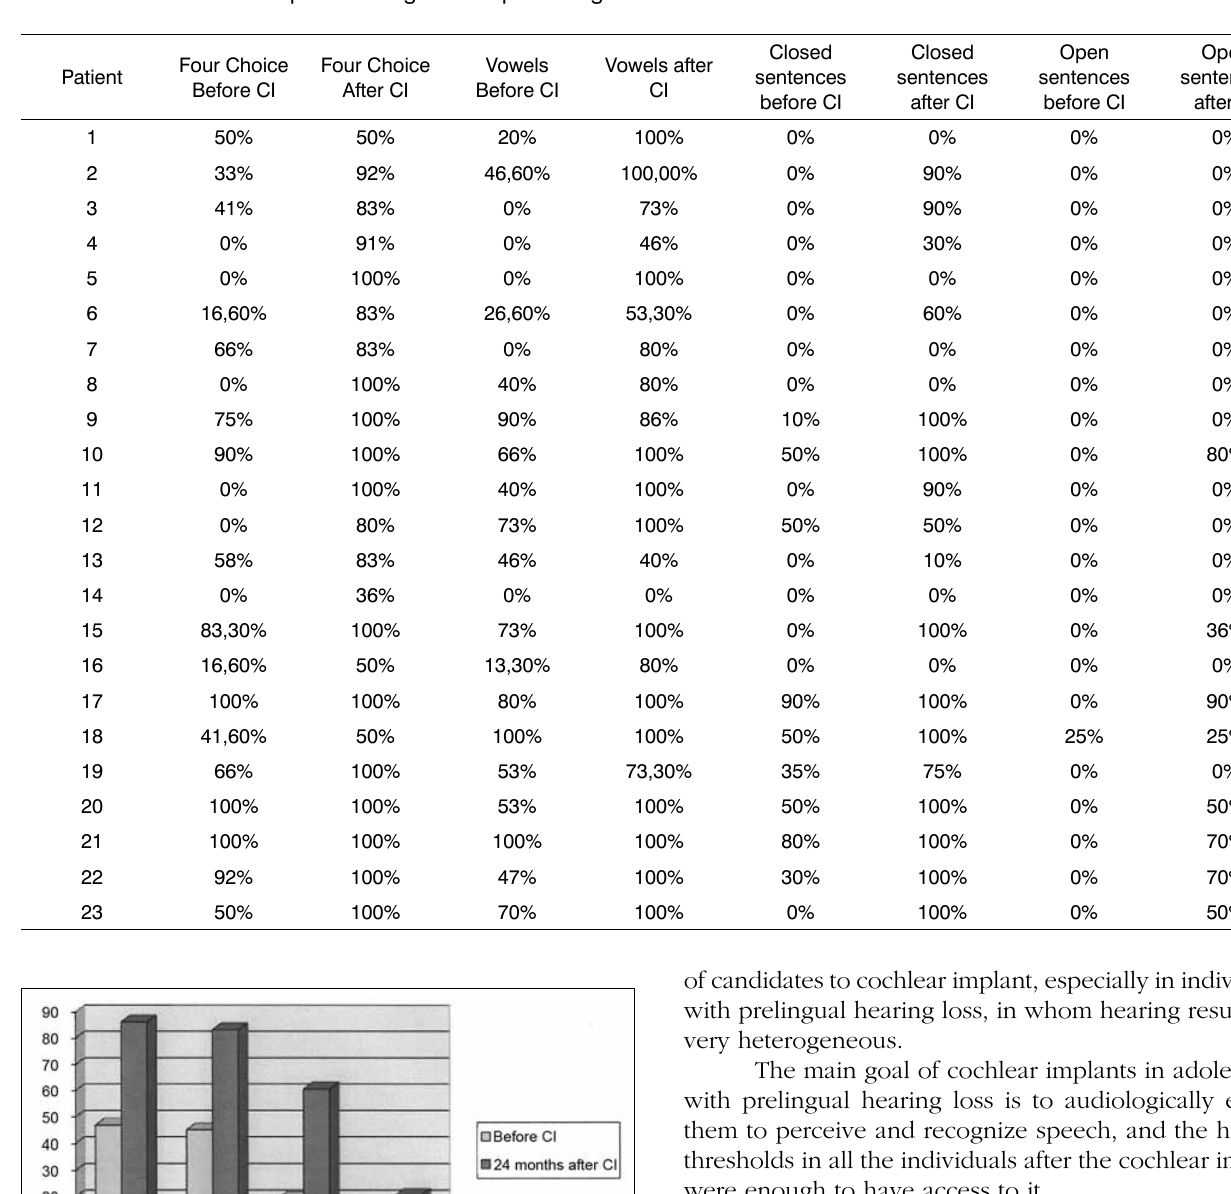
Table 2. Results from the speech recognition in percentages of correct answers.